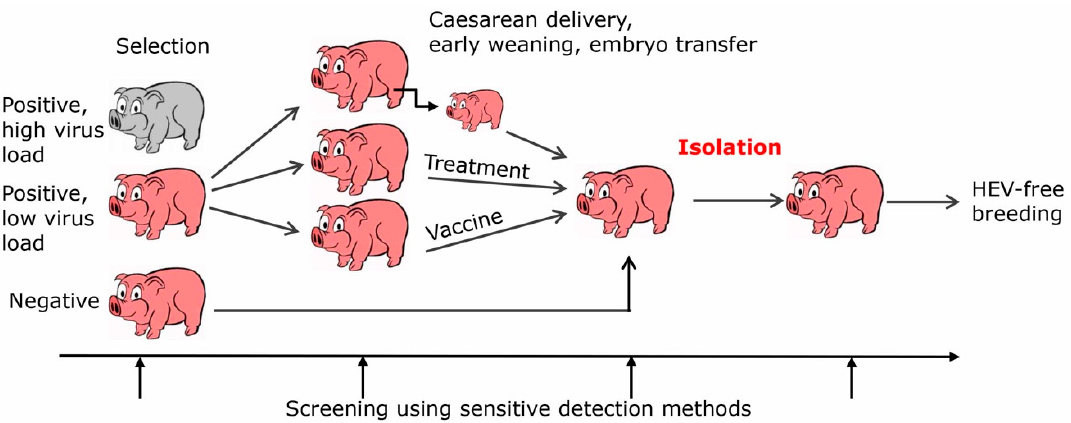
Figure 1. Schematic presentation of strategies to eliminate HEV from pig herds generated for xenotransplantation or pork production.